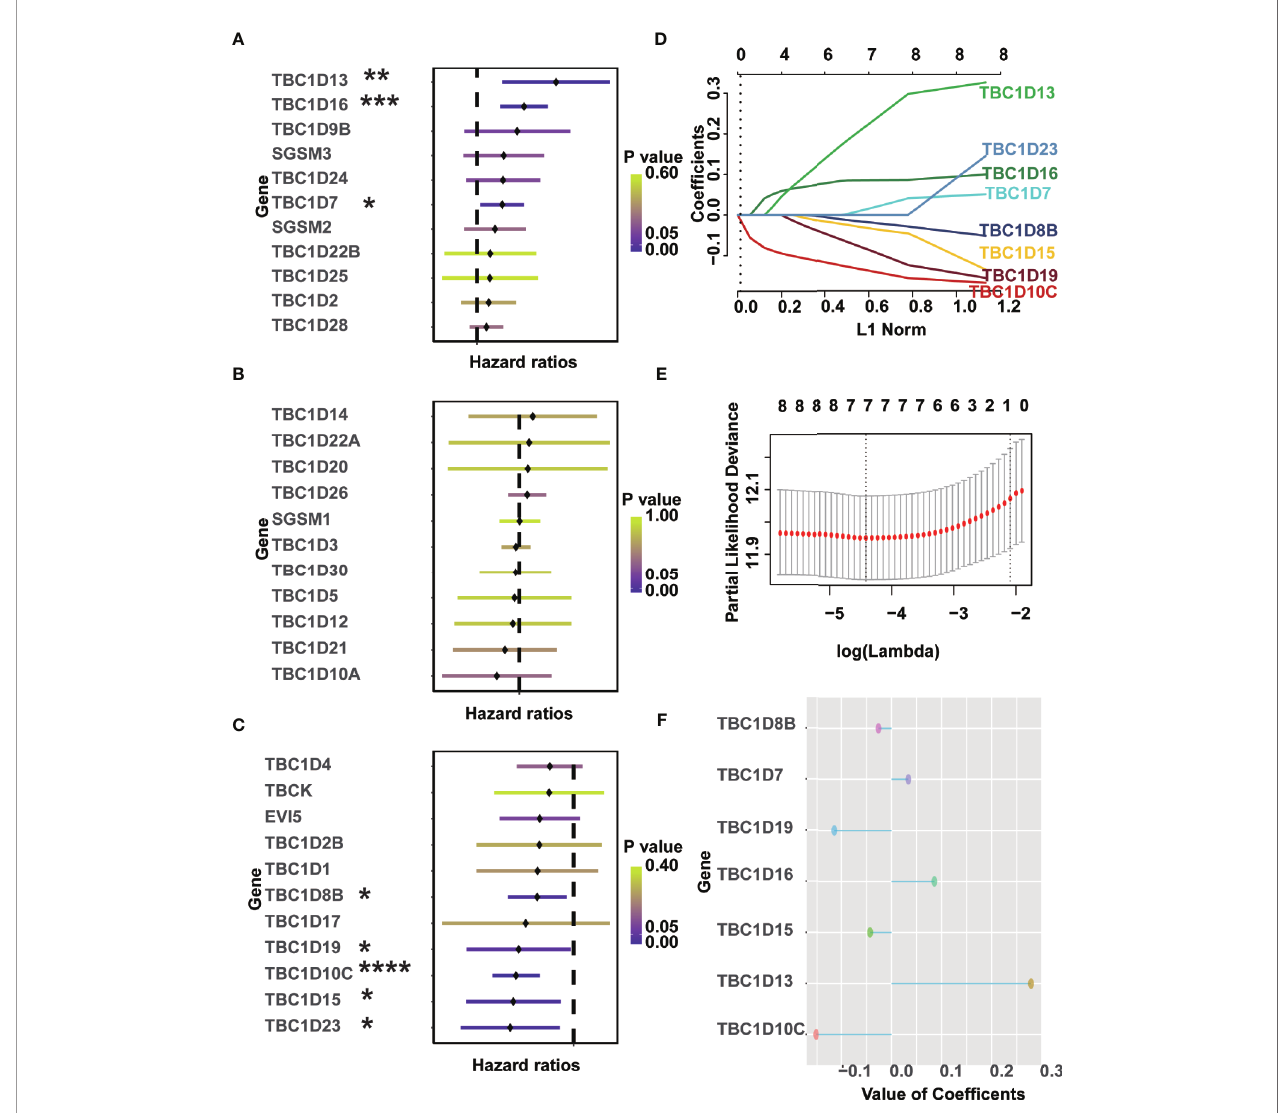
FIGURE 3 | Identi fi cation of prognostic-associated TBCs from TCGA. (A – C) Univariate Cox regression analyses were fi nished to screen prognostic-associated TBCs from TCGA. (D – F) LASSO coef fi cients of the seven prognostic-associated TBCs were calculated and displayed. *p < 0.05, **p < 0.01, ***p < 0.001, **** <